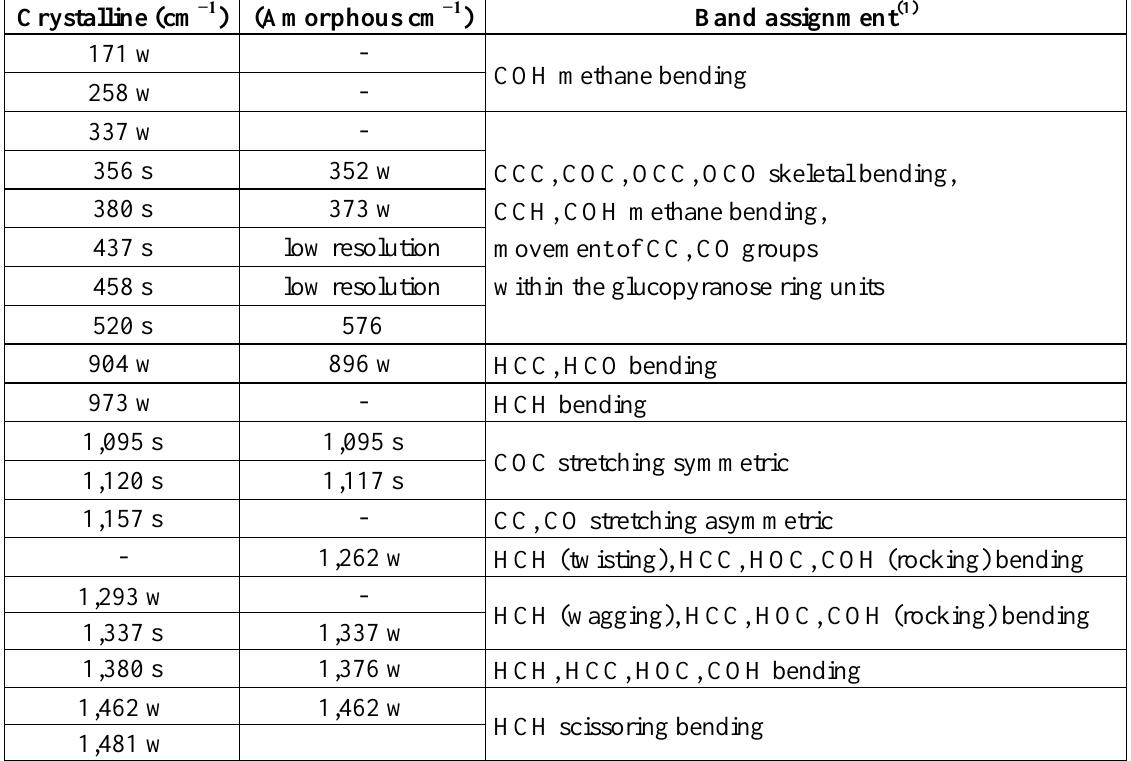
Table 1. Summary of FT Raman frequencies and band assignments of crystalline (microcrystalline cellulose powder Sigma Aldrich) and amorphous (from apple cell walls) celluloses (s—strong,